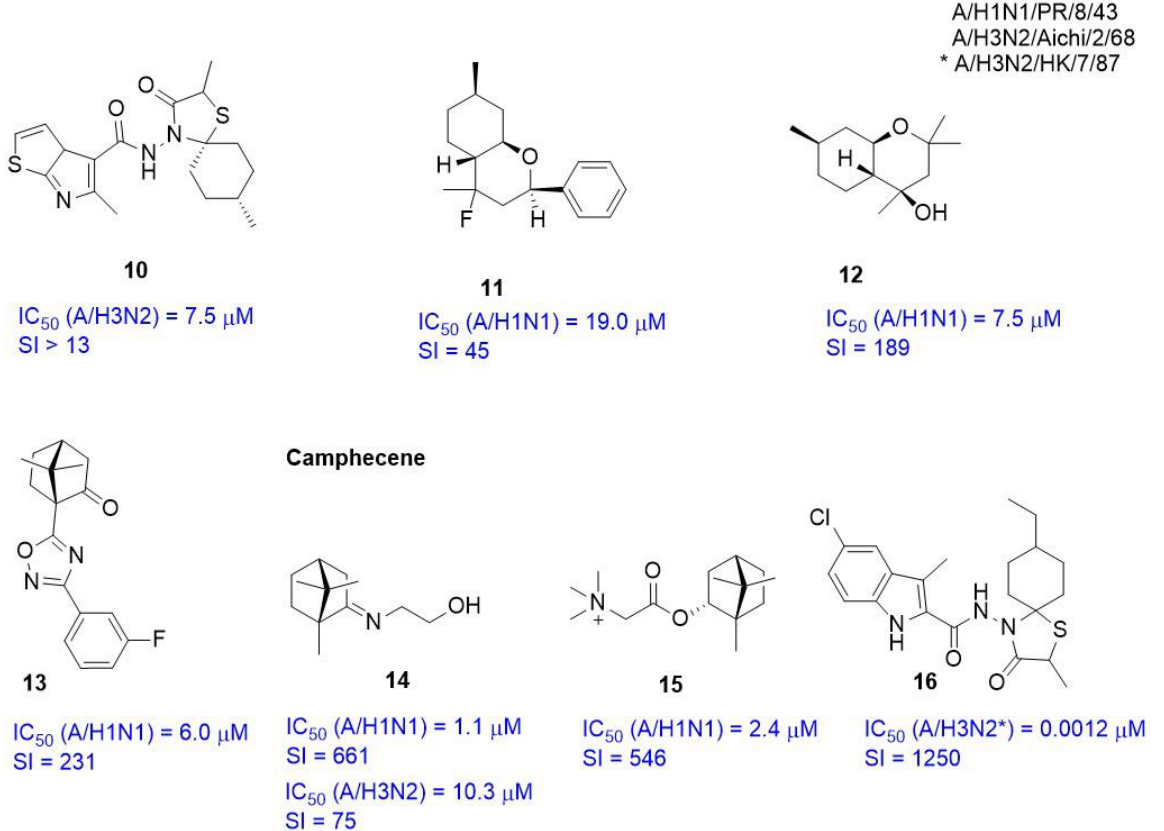
Figure 6. Inhibitors of HA binding in the TBHQ binding site.